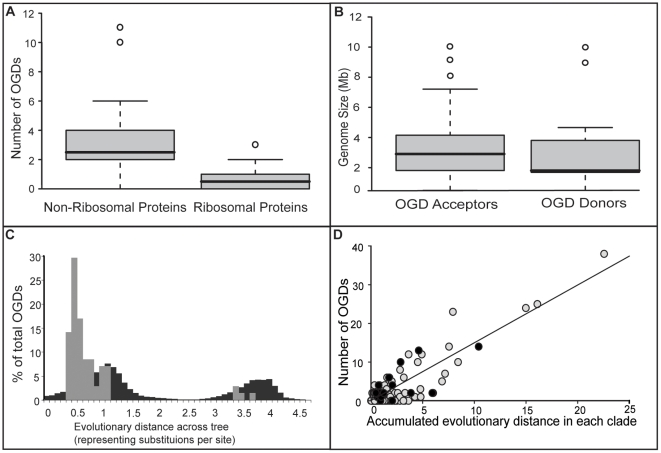
Factors influencing OGDs in single copy genes.A) There is a significant correlation with the biological function of the proteins and their propensity to OGDs (p<0.01 Wilcoxon Mann-Witney test). B) The genome size of the acceptors are significantly larger than the donors (p = 0.02 Wilcoxon Mann-Witney test). C) The OGDs appear to occur between more closely related organisms than would be expected from the shape and structure of the tree in Figure 3 (p = 0.001, Kolmogorov-Smirnov test). In black: all 103,210 possible distances between donors and acceptors based on the tree in figure 3. In grey: the distribution of evolutionary distances between the observed donors and acceptors. The bimodal nature of the distributions stems from the difference in phylogenetic distances between taxa when they are in the same Domain of life versus when they are from different Domains. See Figure 3 for an illustration of the phylogenetic distances involved. D) The rate of OGDs is significantly correlated with evolutionary time/opportunity calculated for all 380 branches of the tree (in grey) and for the 15 chosen independent groups of organisms (in black) p = 0.005.